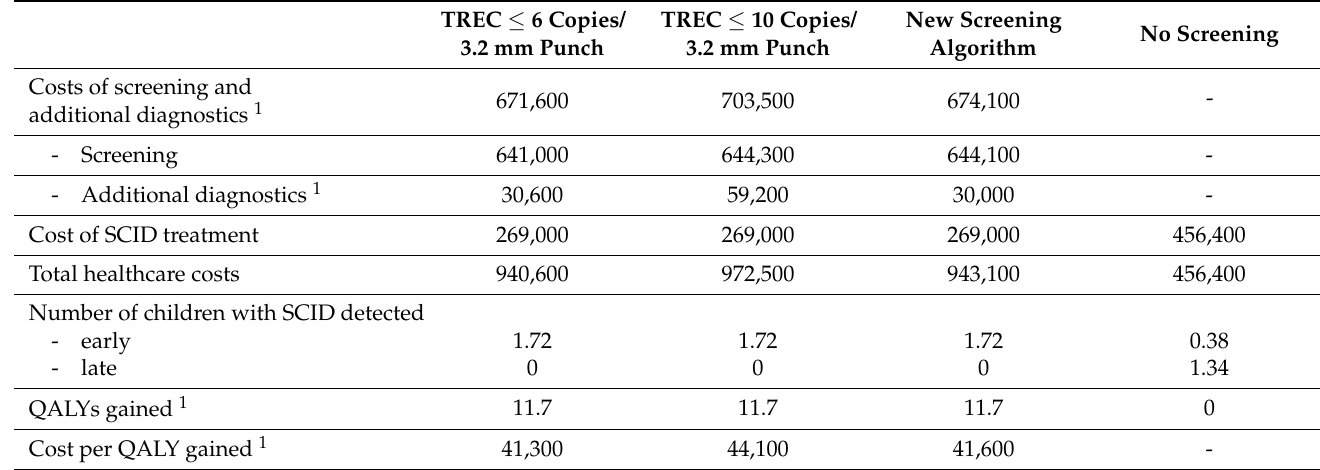
Table 4. Model-based yearly cost and effects per 100,000 infants in a situation with and without newborn screening for SCID, and incremental cost-effectiveness ratios for different screening strategies (in 2020